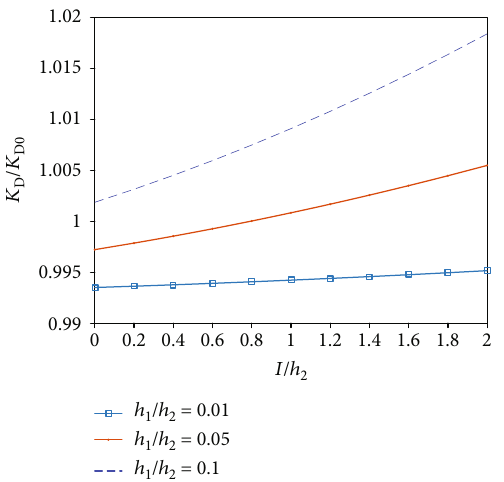
Figure 8: E ff ects of l / h on electric displacement intensity factor for 2 di ff erent h / h 1 2